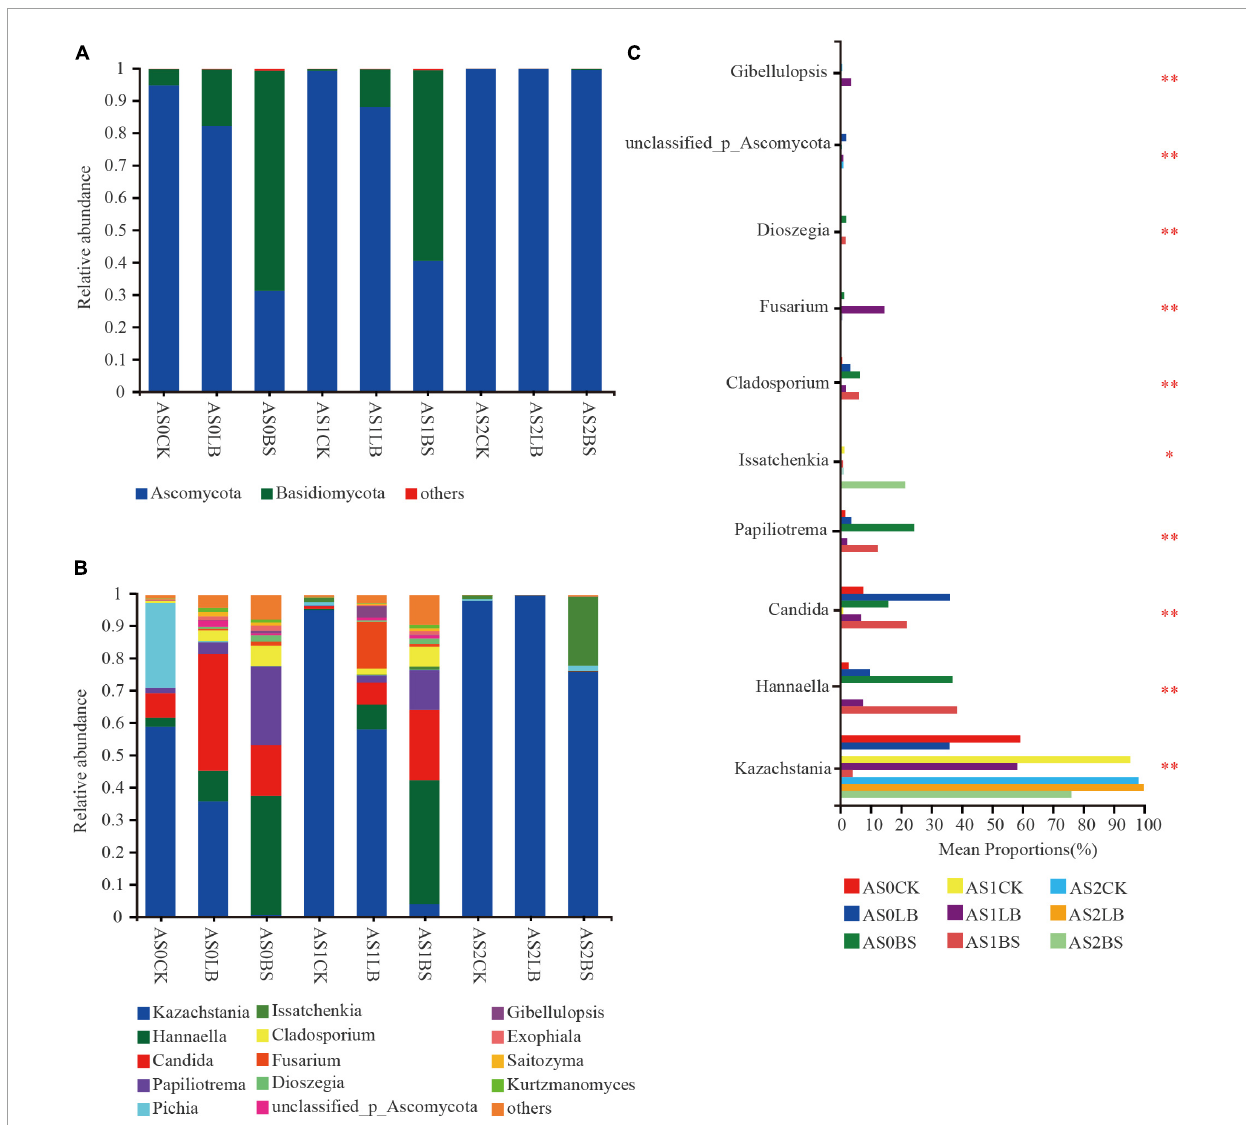
FIGURE7 Dynamic changes in relative abundance of fungi at the phylum level (A) and genus level (B) during aerobic exposure and the differences in genus level (C) . ∗ Significance at P < 0.05; ∗∗ significance at P < 0.01. AS0CK, not inoculated silage at 0 h of aerobic exposure; AS0LB, Lentilactobacillus buchneri inoculated silage at 0 h of aerobic exposure; AS0BS, inoculated Bacillus subtilis silage at 0 h of aerobic exposure; AS1CK, not inoculated silage at 18 h of aerobic exposure; AS1LB, Lentilactobacillus buchneri inoculated silage at 18 h of aerobic exposure; AS1BS, inoculated Bacillus subtilis silage at 18 h of aerobic exposure; AS2CK, not inoculated silage at 60 h of aerobic exposure; AS2LB, Lentilactobacillus buchneri inoculated silage at 60 h of aerobic exposure; AS2BS, inoculated Bacillus subtilis silage at 60 h of aerobic